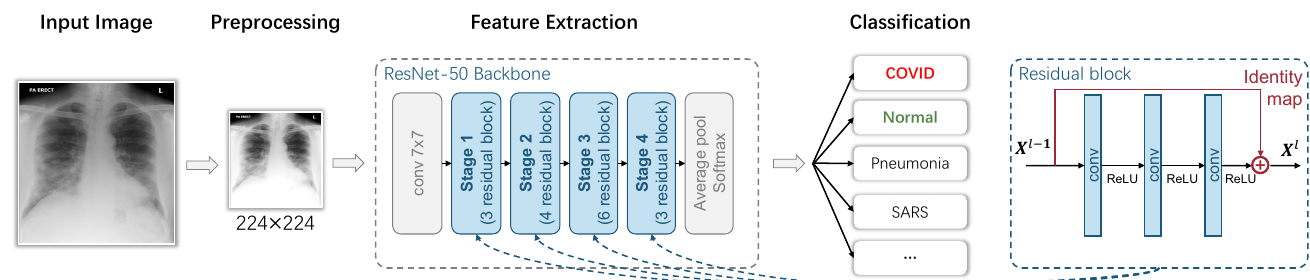
Figure 4. A typical ResNet-classification-based image-level COVID-19 diagnosis